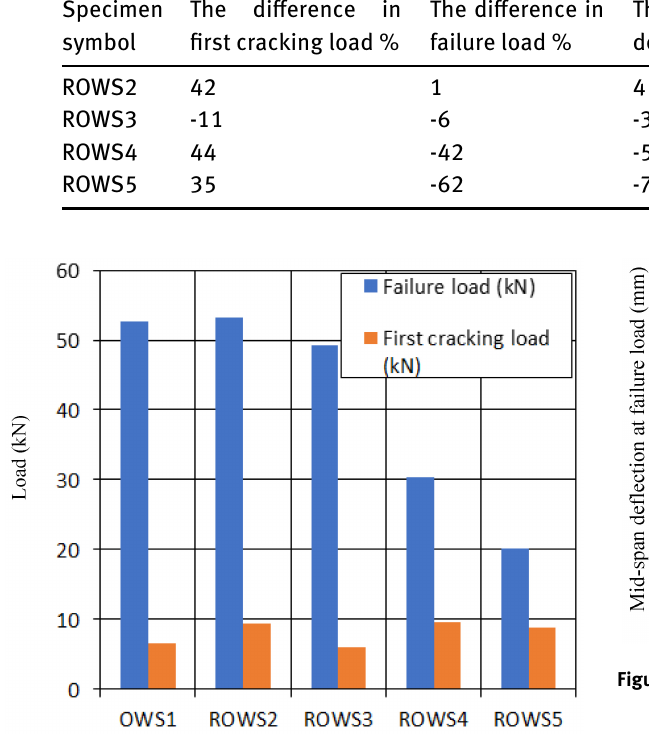
Figure 12: Failure and first cracking loads for all specimens.